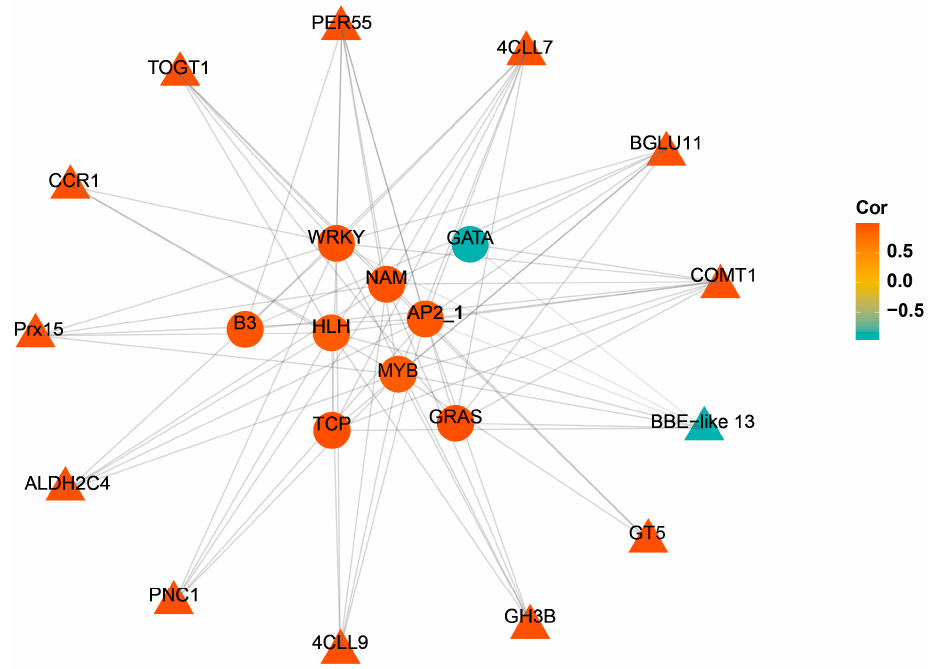
Figure 4. Transcription factor–gene network in A. sinensis lignin biosynthesis. Triangles represent genes and circles represent transcription factors. Cor represents Pearson correlation. Orange represents positive correlation and green represents negative correlation.